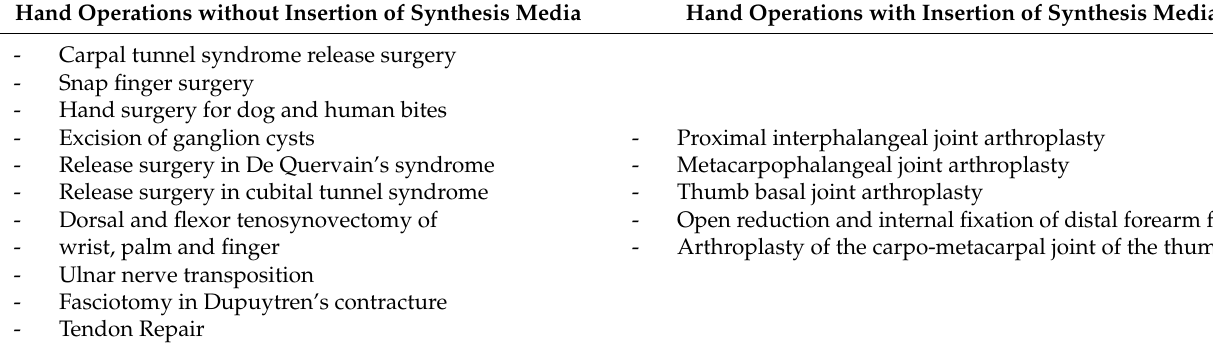
Table 1. Main hand surgeries, divided on the basis of the use or not of synthetic means. Hand Operations without Insertion of Synthesis Media Hand Operations with Insertion of Synthesis